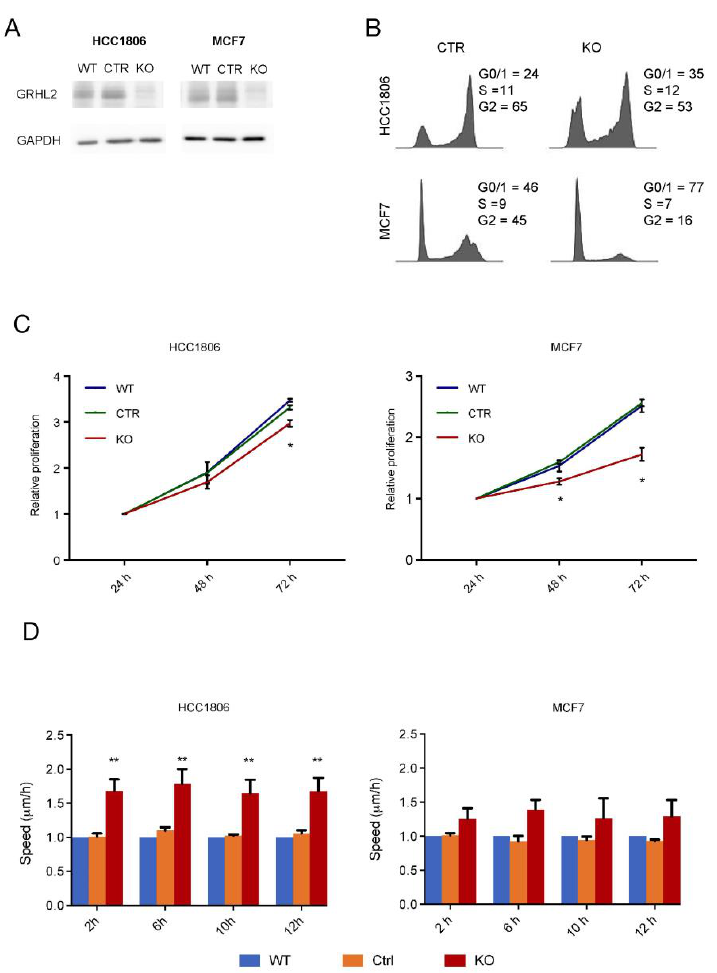
Figure 4. Response to GRHL2 knockout in luminal and basal A cells. ( A ) Western blot analysis showing loss of GRHL2 in KO cells. WT, wild type cells; CTR, sgCTR transduced cells; KO, sgGRHL2 transduced cells. ( B ) FACS profiles with associated quantification of cell cycle phase distribution in sgCTR (CTR) and sgGRHL2 transduced (KO) MCF7 and HCC1806 cells. Representative experiment from 2 and 3 biological replicates is shown for MCF7 and HCC1806, respectively. ( C ) Graphs